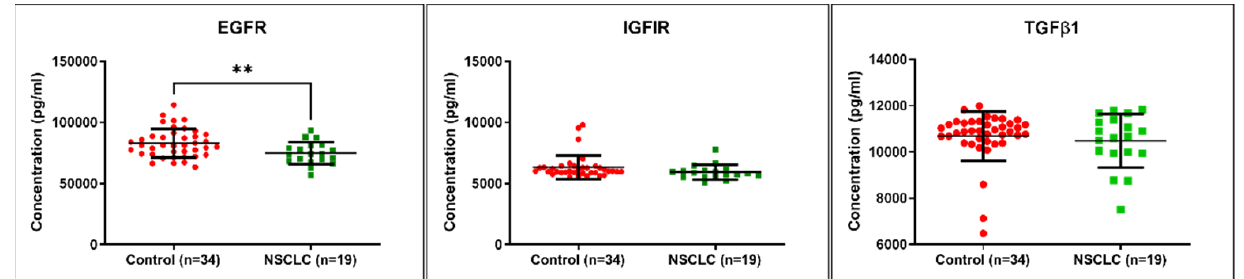
Figure 7. EGFR, IGF-IR, and TGF β 1 quantification in serum of male NSCLC patients ( n = 19) and healthy subjects ( n = 34) using ELISA ( ** p ≤ 0.01 ).